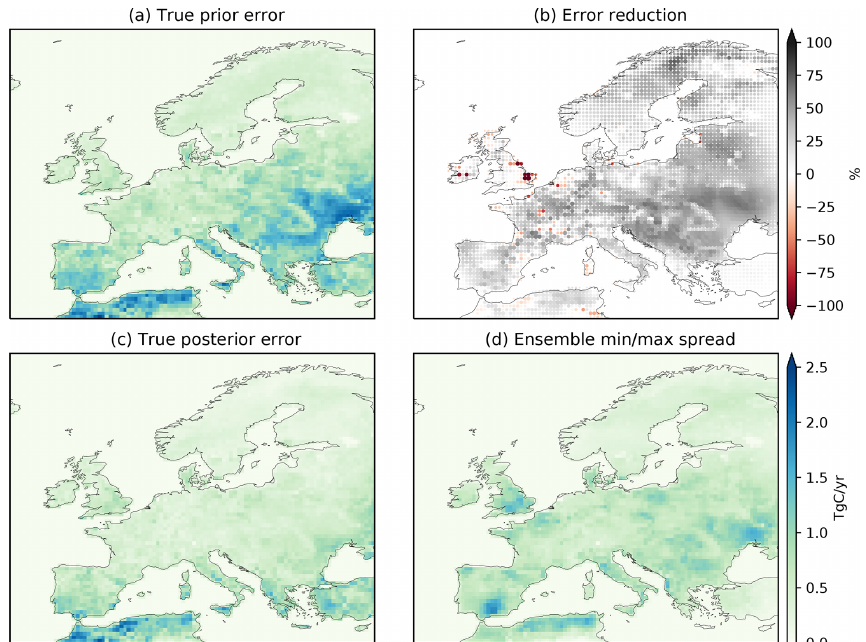
Figure 6. Prior (a) and posterior (c) total error (with respect to the prescribed truth); (b) percentage error reduction. The size of the dots is proportional to the size of the flux correction. (d) Spread of the posteriors throughout the ensemble of sensitivity tests.